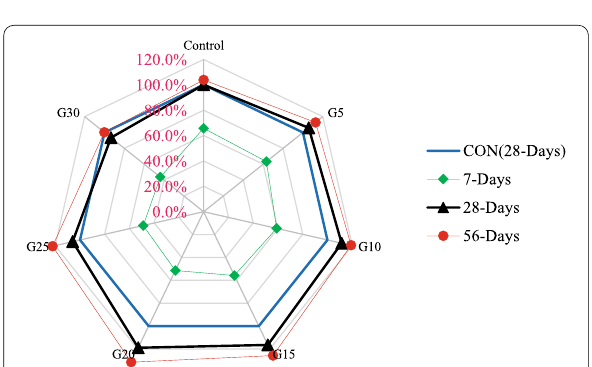
Fig. 17 Relative analysis of flexure strength test